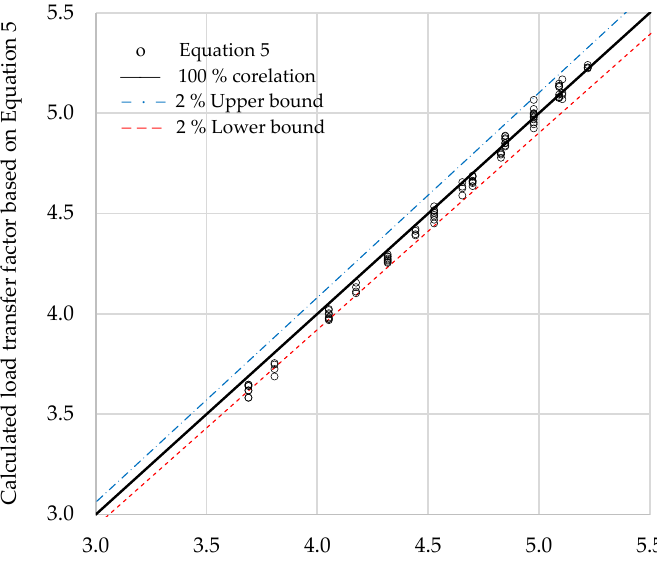
Figure 3. Load-transfer factors ( ζ ) from PLAXIS 2D versus equivalent ζ factors from Randolph [11], for about 100 cases ( L = 10–25 m, L / r 0 = 20–90, υ s = 0.2–0.3, G = 3.8–7.7 Calculated load transfer factor based on Equation 3 under